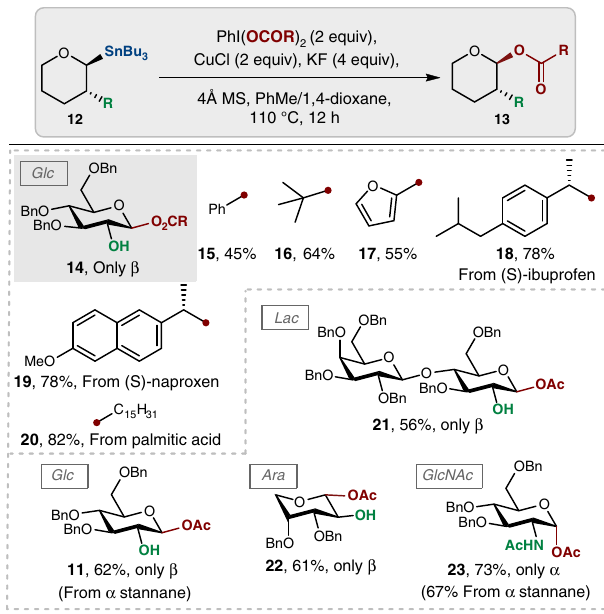
Fig. 2 Scope of oxidative acylation of glycosyl C1 stannanes. In all cases, the formation of only one anomer was observed (based on the 1 H NMR analysis of the unpuri fi ed reaction mixtures). Phenyliodonium dicarboxylates were obtained from iodosobenzene diacetate and the corresponding carboxylic